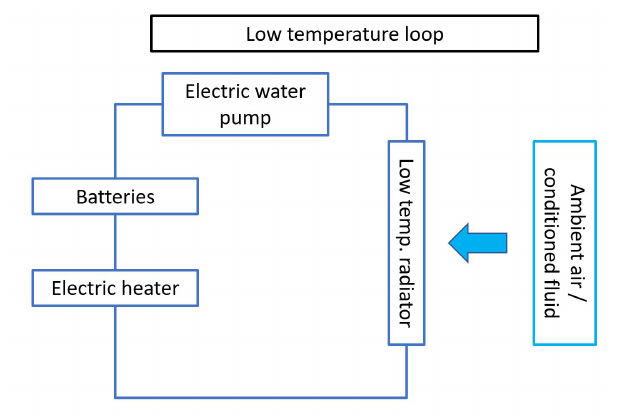
Figure 3. Scheme of a low temperature